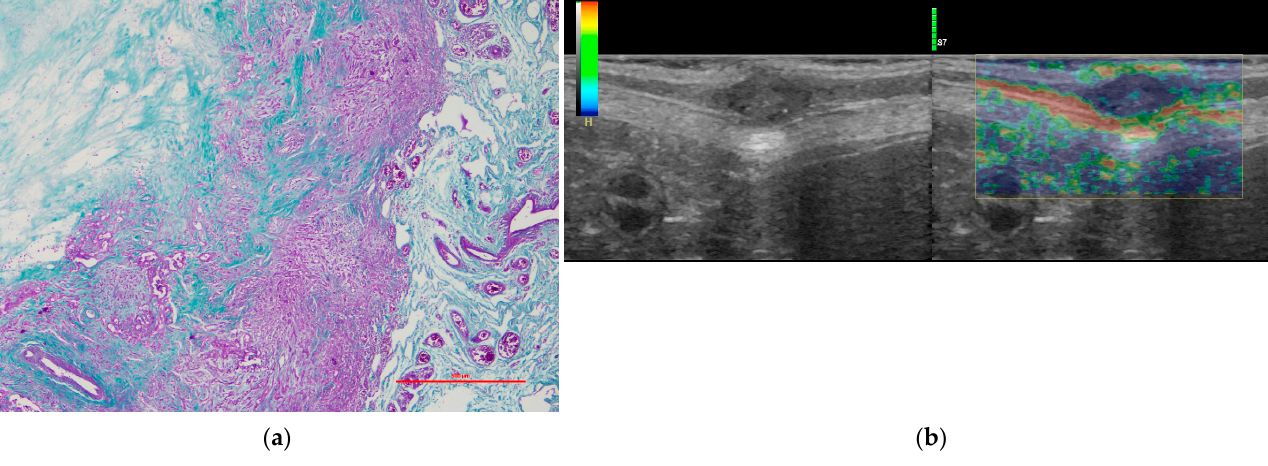
Figure 2. Representative image of a mass confirmed as an anaplastic carcinoma. ( a ) Histological detail of an anaplastic carcinoma with wide areas of fibrosis (Masson´s Trichrome). ( b ) B ‐ mode and elastographic images scored as 4 in the visual scale, corresponding to the same anaplastic carcinoma sample.